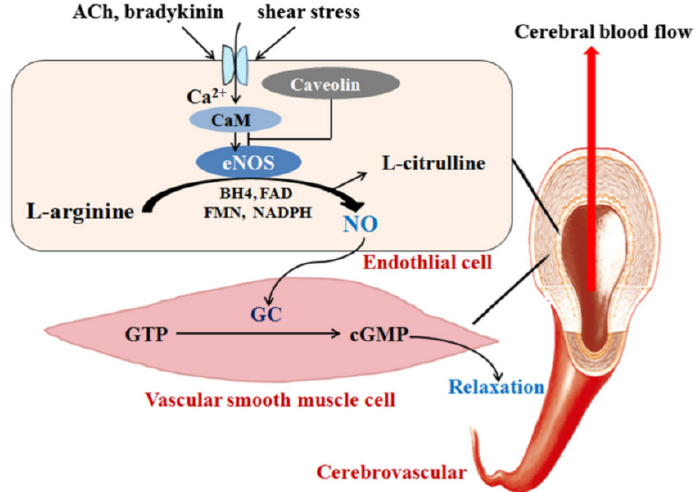
Figure 3. eNOS and its role in the regulation of CBF. eNOS is activated by ACh, bradykinin, shear stress, etc., and then catalyzes L-arginine to generate NO which moves into vascular smooth muscle cells, reacts with GC, and promotes the conversion of GTP into cGMP, resulting in vascular smooth muscle relaxation and the CBF increase. eNOS: Endothelial oxide synthase, CBF: cerebral blood flow, Ach: Acetylcholine, NO: nitric oxide, GC: guanylate cyclase, GTP: guanosine triphosphate, cGMP: cyclic guanosine monophosphate. Reproduced with permission from